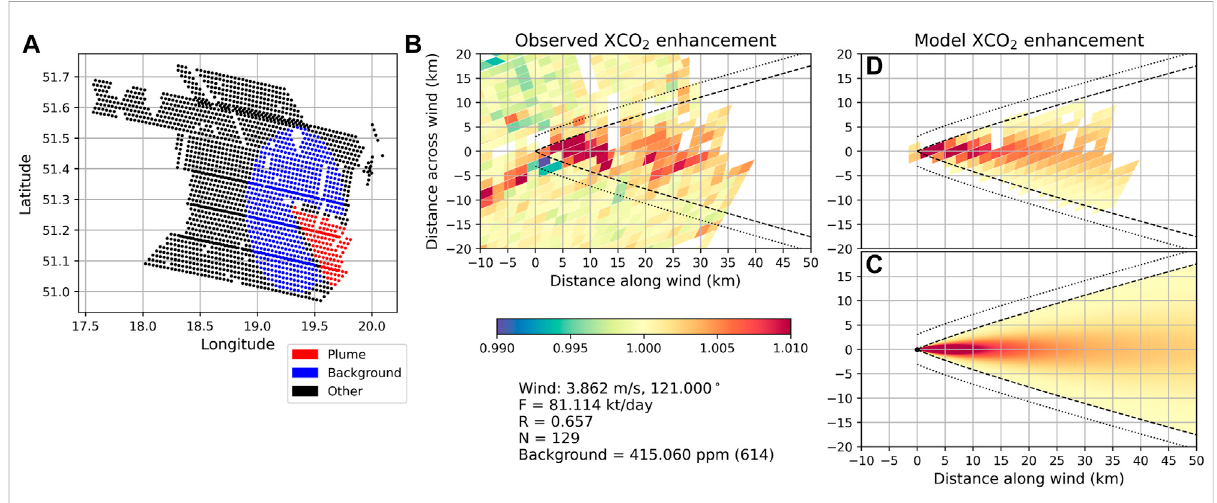
FIGURE 4 CO 2 emission quanti fi cation from the OCO-3 Be ł chat ό w SAM on 2020-04-10. (A) Dots representing footprints are colored as enhancement (red), background (blue) and other (black). (B) Observed XCO 2 footprints relative to the background value with the positive x -axis aligned with the wind direction. (C) Gaussian plume model XCO 2 enhancement with dotted lines denoting a region between the enhancement and background. (D) Model XCO 2 enhancements as would be seen by OCO-3 and used in the observation-model fi t.